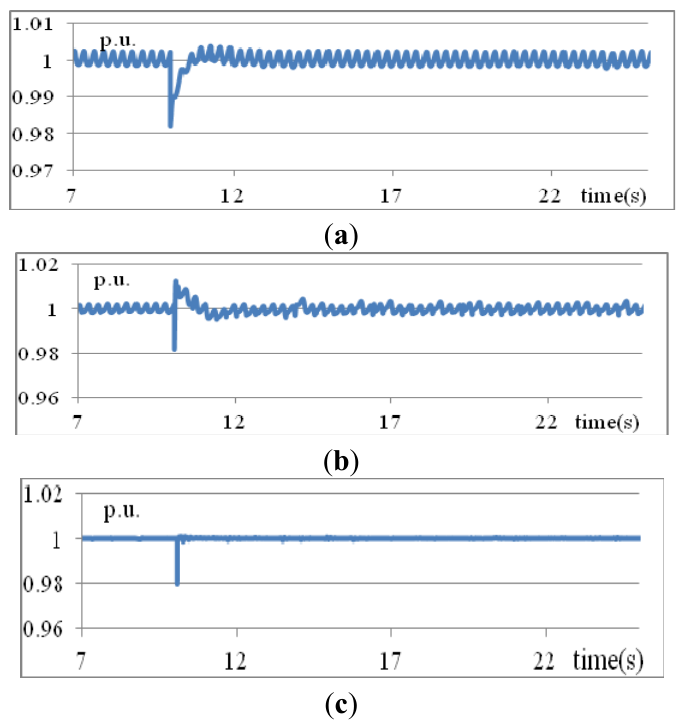
Figure 7. Voltages at bus 3 obtained using three methods: ( a ) traditional PID; ( b ) T1 fuzzy rules; ( c ) IT2 fuzzy rules (Scenario